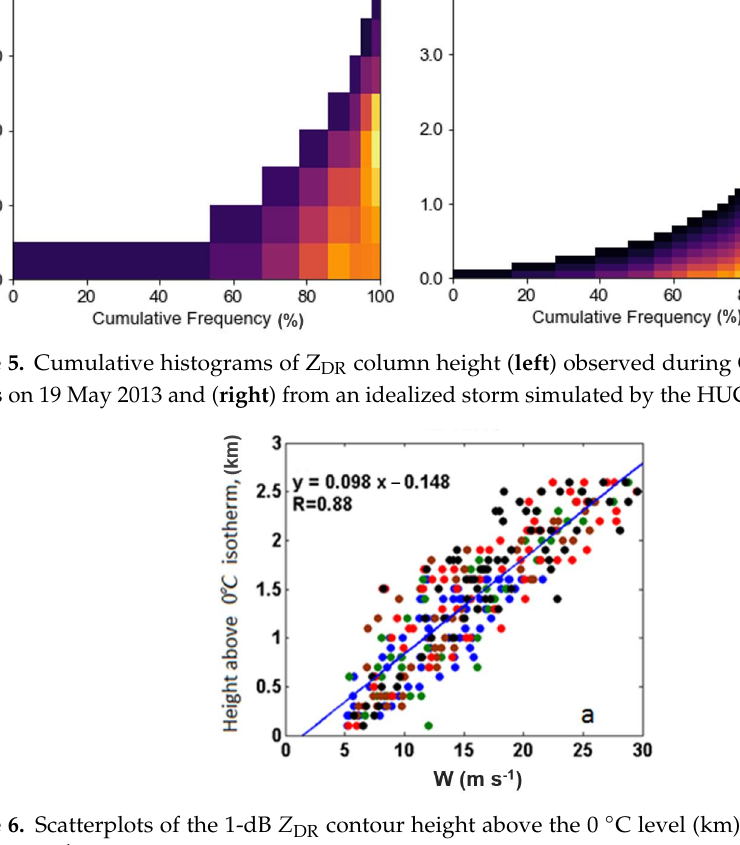
Figure 6. Scatterplots of the 1-dB Z DR contour height above the 0 °C level (km) versus the updraft speed (m s − 1 ) at that height. Different concentrations of CCN are marked by different colors: blue—100 cm − 3 , green—400 cm − 3 , brown—1000 cm − 3 , red—2000 cm − 3 , and black—3000 cm − 3 . Adapted from Ilotoviz et al. [77]. Used with permission from American Meteorological Society.